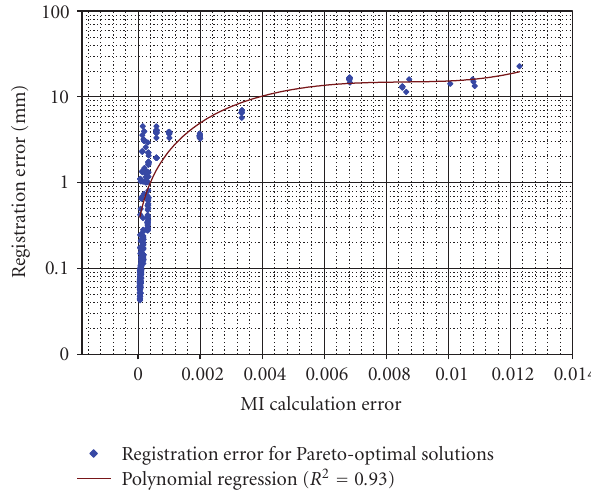
Registration error for Pareto-optimal solutions Polynomial regression ( R 2 = 0 . Figure 9: Relationship between MI calculation error and image registration error for an example application of CT-CT